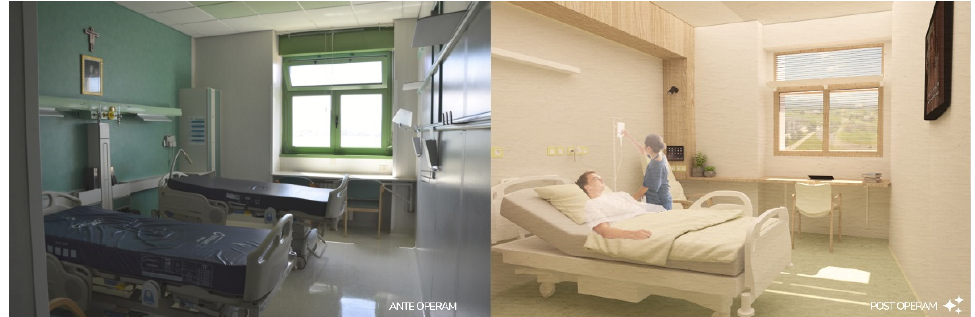
Figure 18. Ante operam and post operam comparison, room 1.